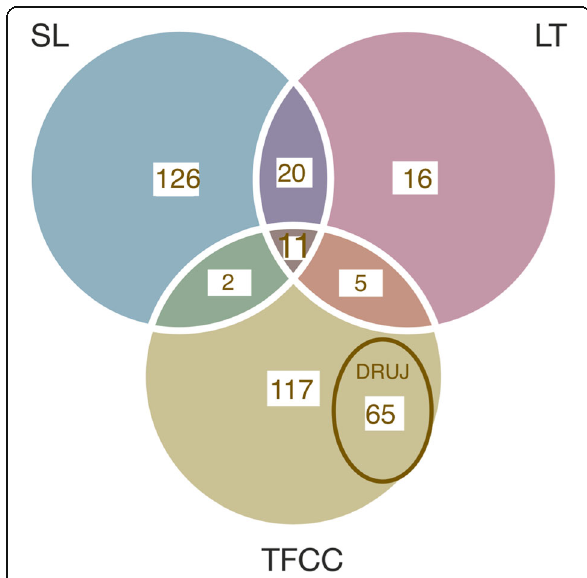
Fig. 4 The distribution (n) of the included studies on different wrist ligaments injuries and injury combinations. (SL = scapholunate ligament, LT = Lunotriquetral ligament, TFCC = Triangular fibrocartilage complex, DRUJ = Distal radioulnar joint)